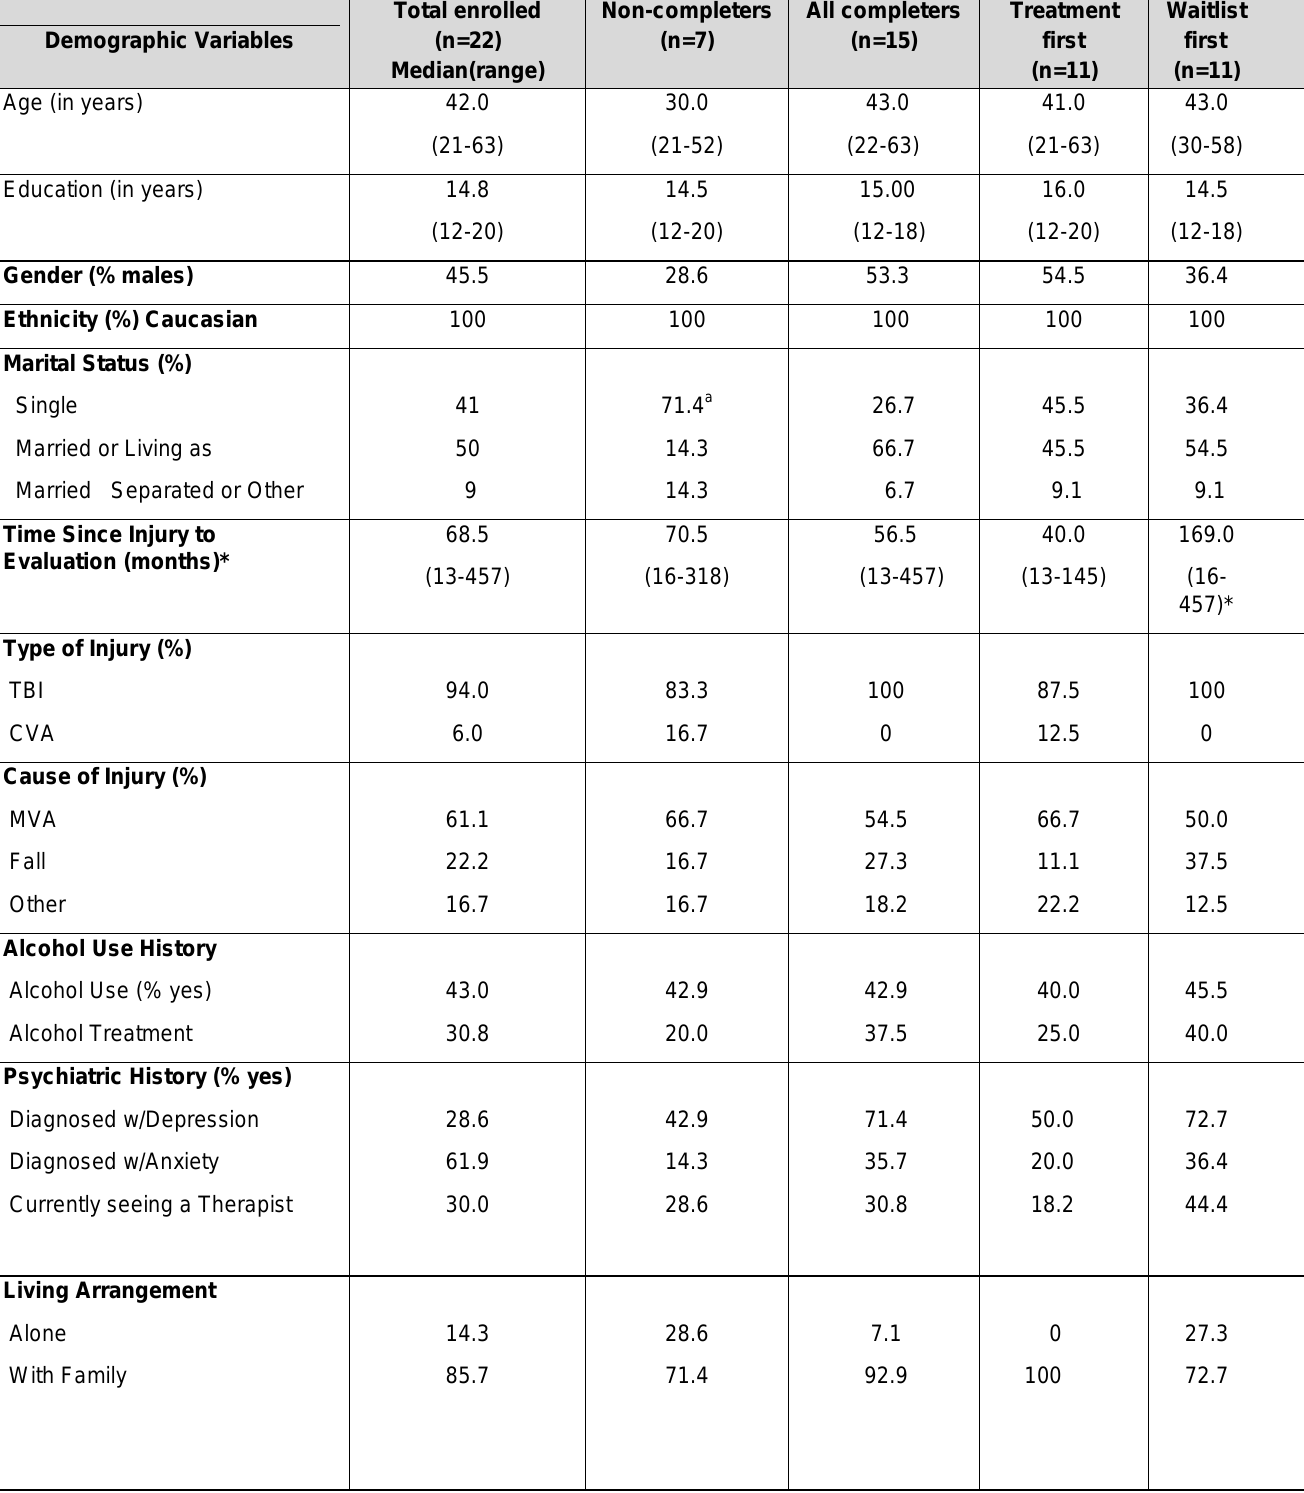
Table 1. Descriptive Summaries for Demographic and Injury